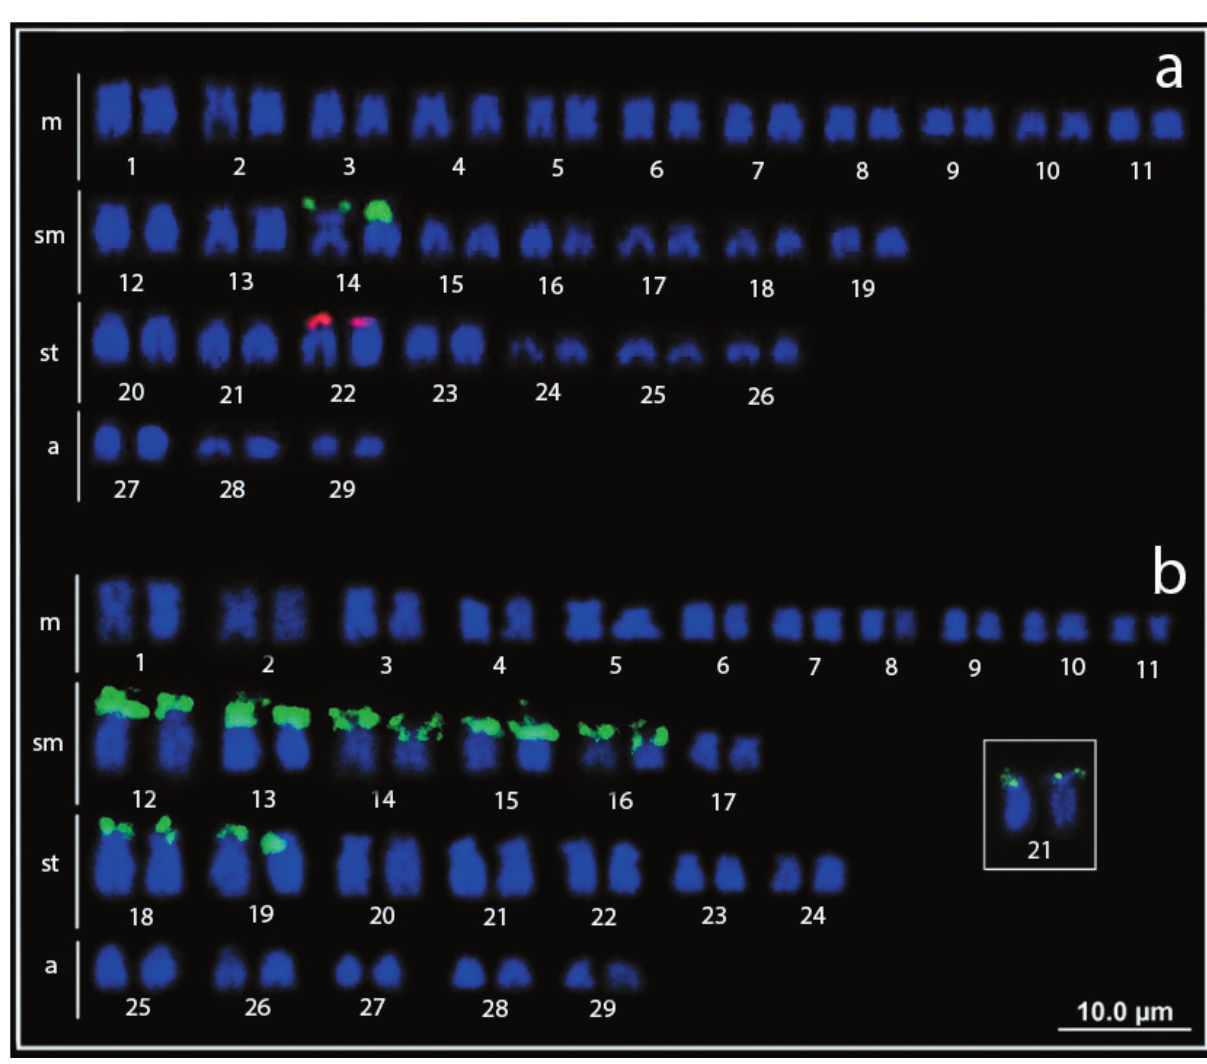
Figure 3. Karyotypes of Auchenipterus nuchalis ( a ) and Entomocorus radiosus ( b ) hybridized with rDNA 18S probes (pair 14 of A . nuchalis and pair 21 in box of E . radiosus , green signal) and rDNA 5S probes (red signal in the pair 22 of A . nuchalis and green signal in the pairs 12, 13, 14, 15, 16, 18 and 19 of E . radiosus ), counterstained with DAPI. rDNA = ribosomal DNA and DAPI =